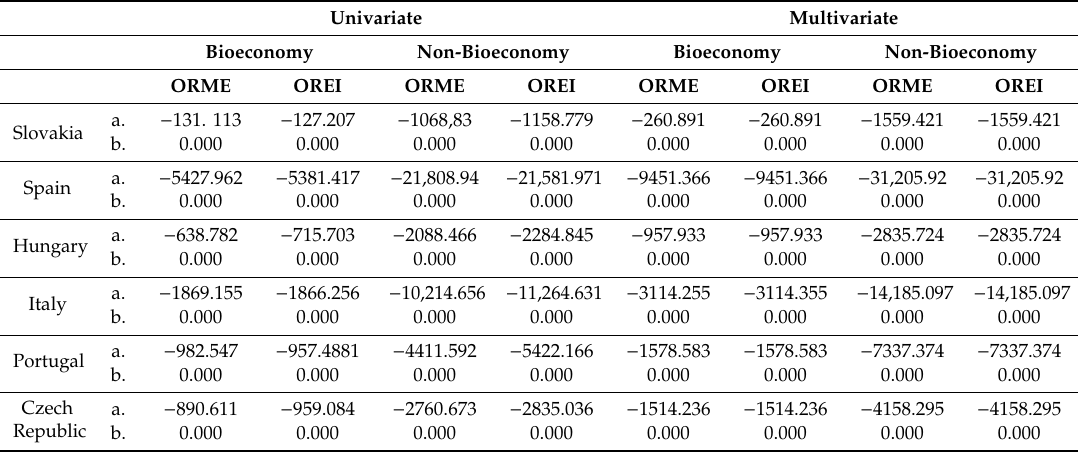
Table 3. Validity and statistical significance of the models. Univariate Multivariate Bioeconomy Non-Bioeconomy Bioeconomy